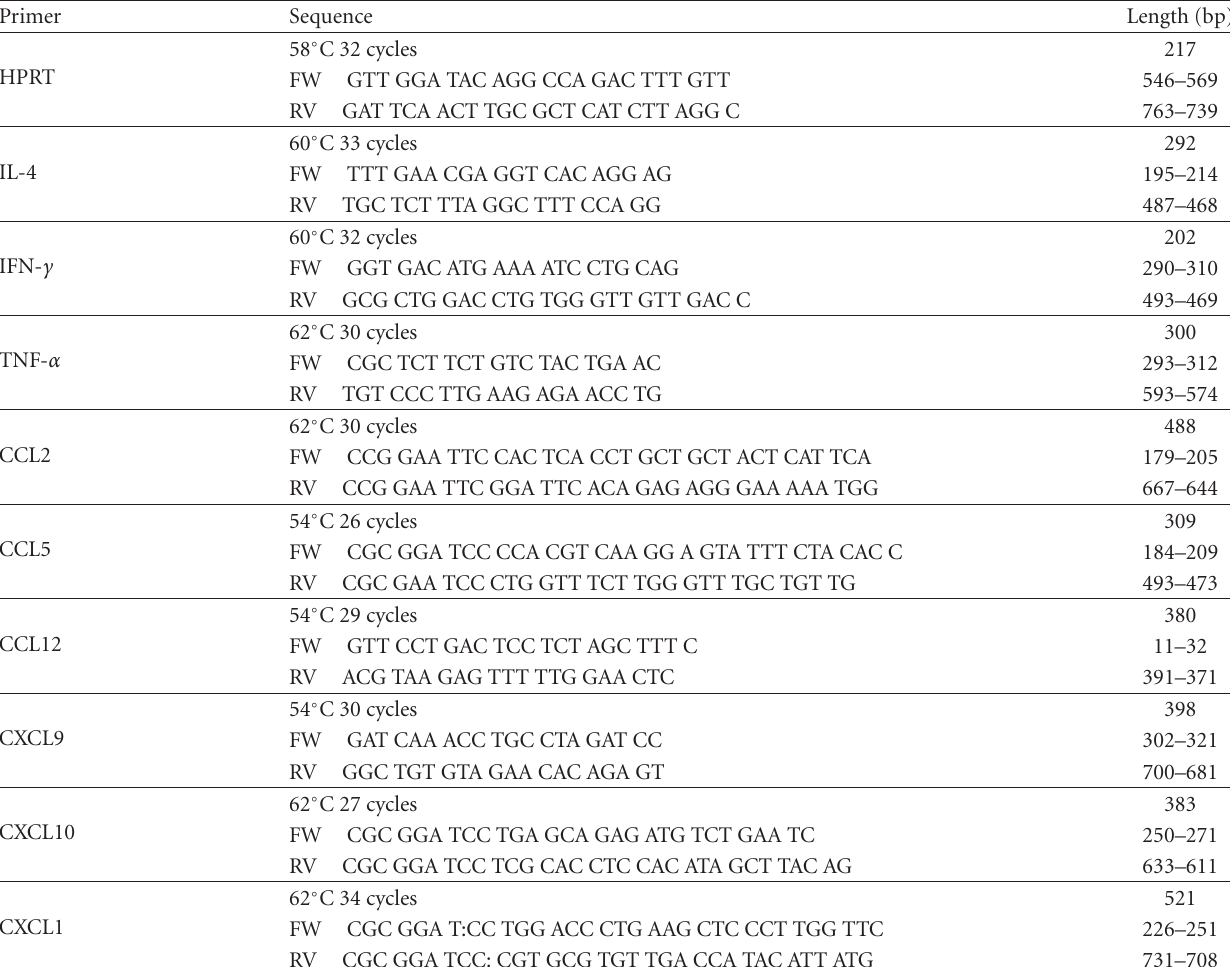
Table 1: Primers, temperature, and number of cycles used for